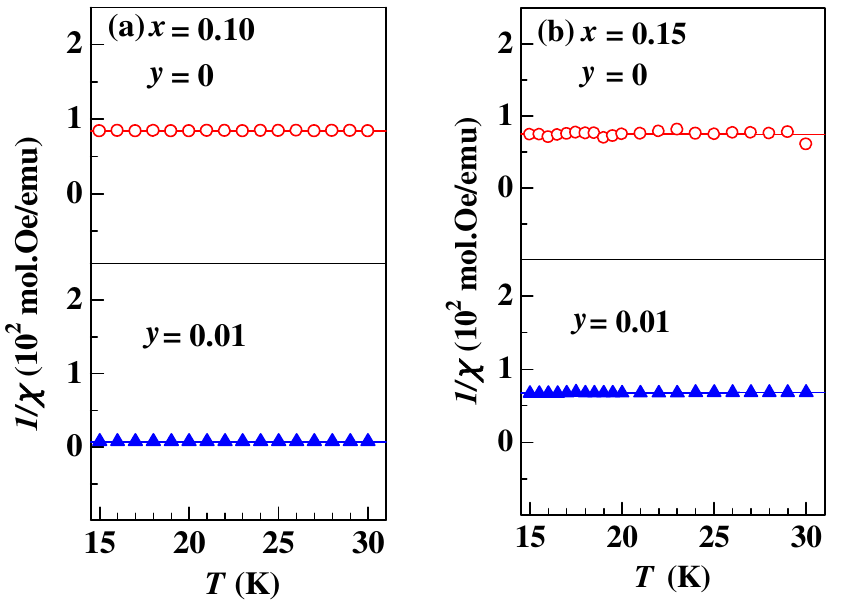
Figure 5. The graph of 1/ χ versus T for Eu 2 − x Ce x Cu 1 − y Zn y O 4+ α − δ with x = 0.10 ( a ) and 0.15 ( b ).